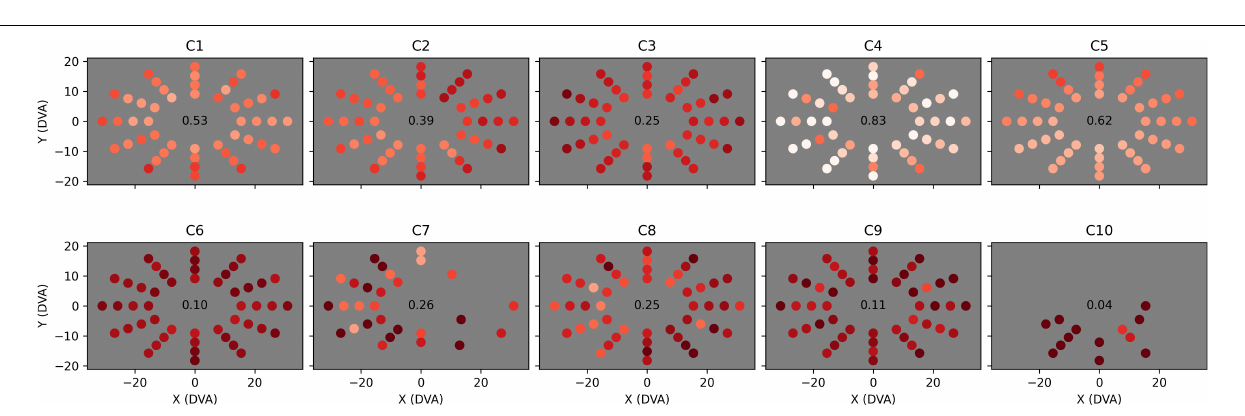
FIGURE 8 | Proportion of saccades to each tested location that were direct. The layout of each plot is identical to Figure 7 , but the color of each dot now represents the proportion of valid trials at that location that were completed with direct eye movements only (i.e., eye movements that did not stray out of a narrow strip between the start location and the target location), ranging from dark red (0% direct) to white (100% direct). Locations at which less than three valid trials were completed are left empty (C7 and C10). Overall mean direct proportion is shown in the center of each